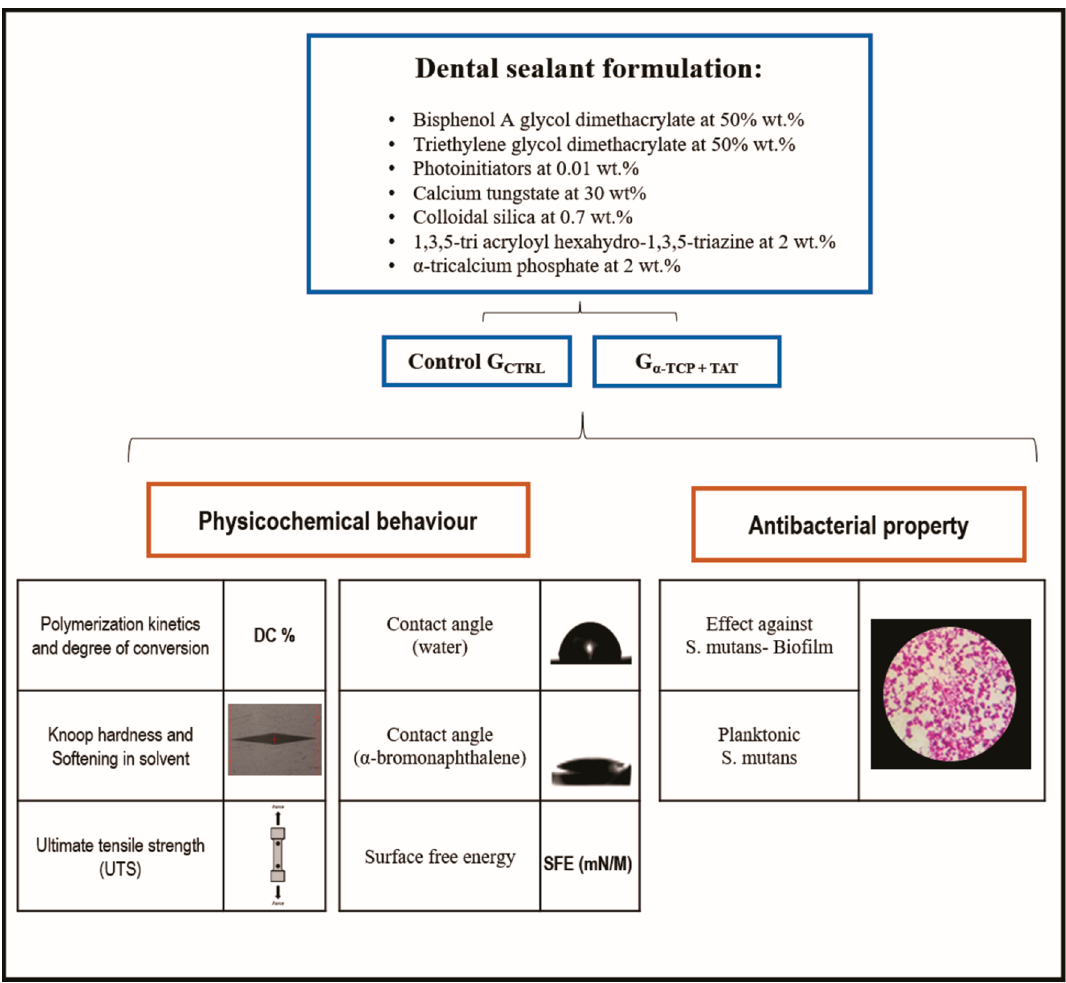
Figure 1. Schematic draw of the study design.